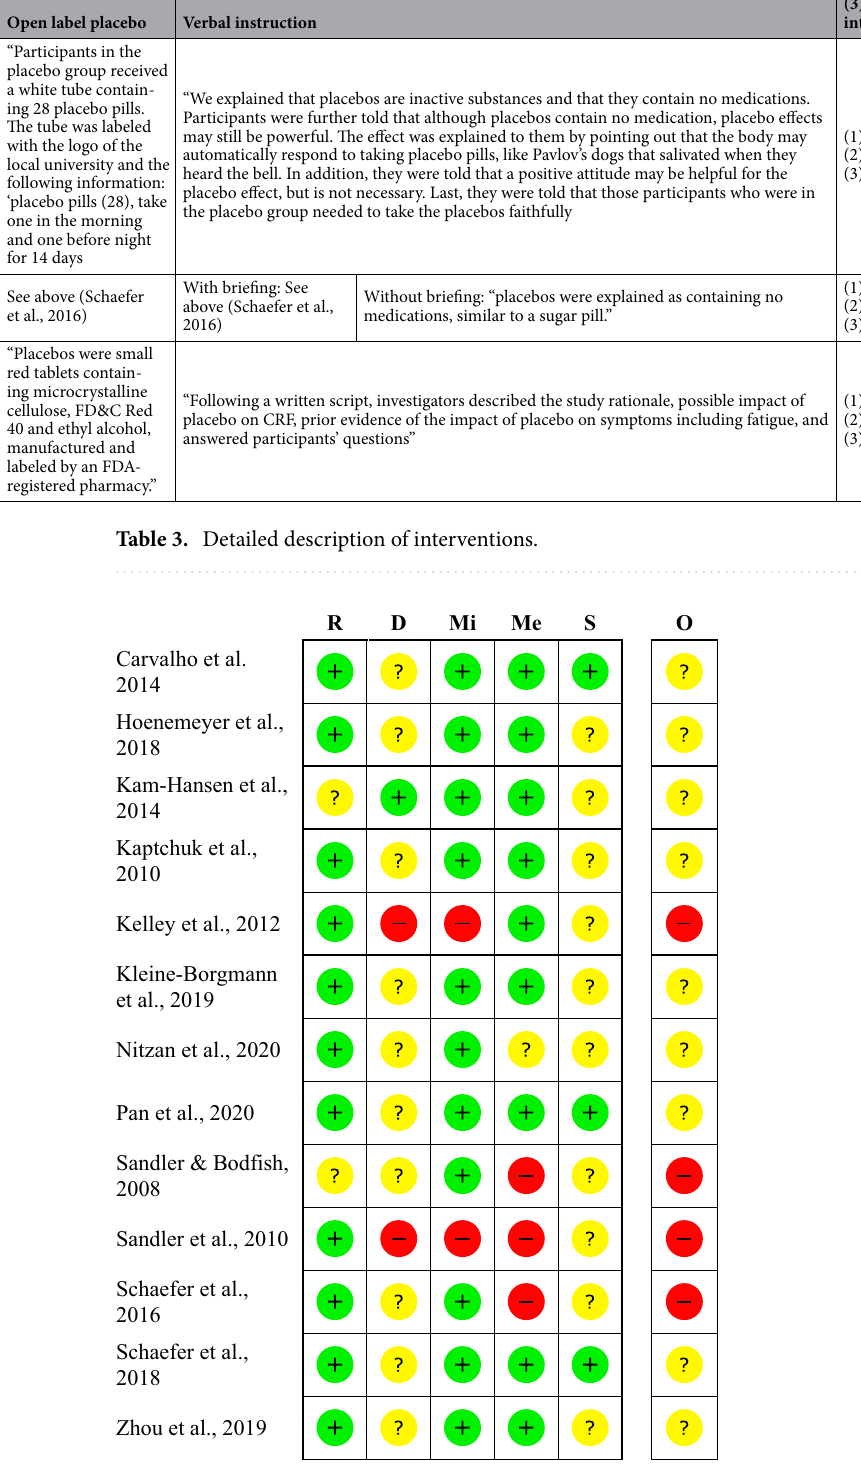
Figure 2. Within studies ‘risk of bias assessment for RCT on five ROB 2 criteria and overall. The risk of bias evaluation in the categories: bias arising from the randomization process (R), bias due to deviations from intended interventions (D), bias due to missing outcome data (Mi), bias in measurement of the outcome (Me), bias in selection of the reported result (S); overall risk of bias (O). Red symbols: high risk of bias; yellow symbols: some concerns; green symbols: low risk of